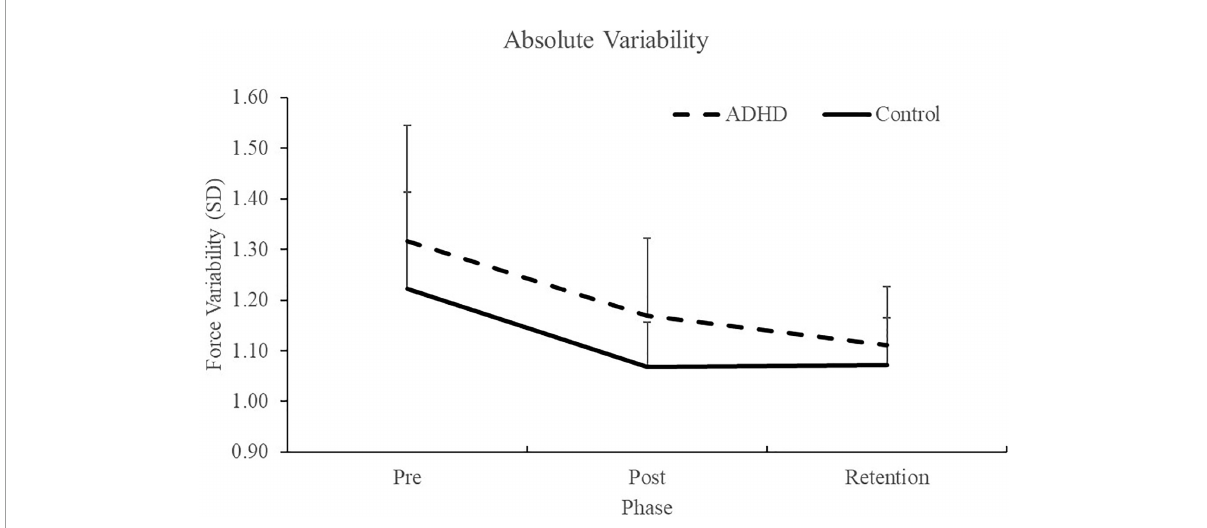
FIGURE6 Absolute (raw) performance scores for each phase when assessing trace error. ADHD scores are in the dashed line and controls are in the solid line. Pre and post measures were collected on day one and the retention test occurred 24–48 h later. Values represent mean ±